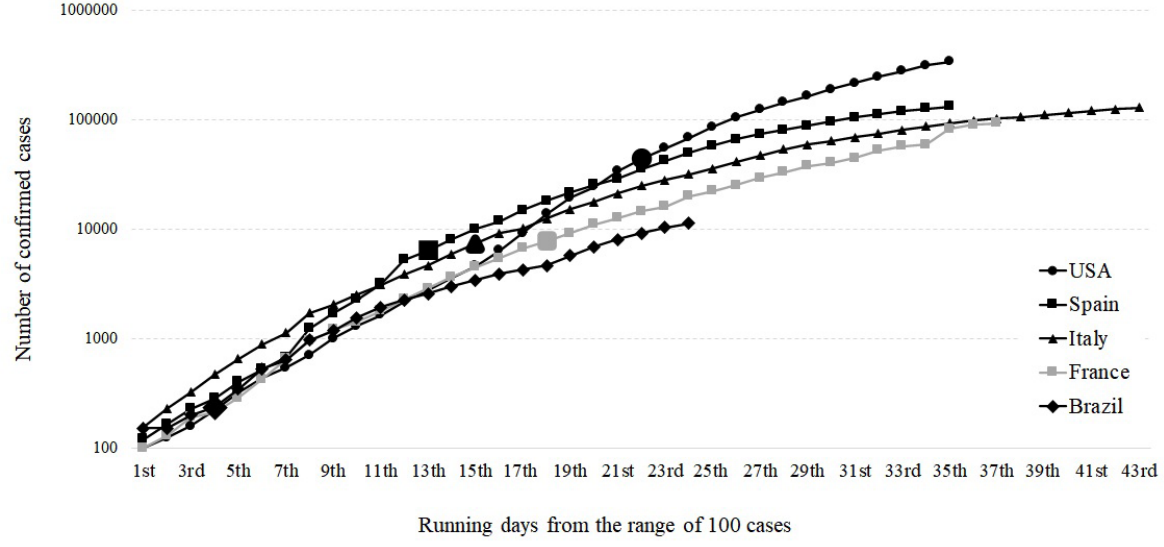
Figure 6. Graphic shows the relationship between the speed of the exponential increase in cases of COVID-19 between countries and the beginning of the adoption of social isolation measures (points highlighted). Source: